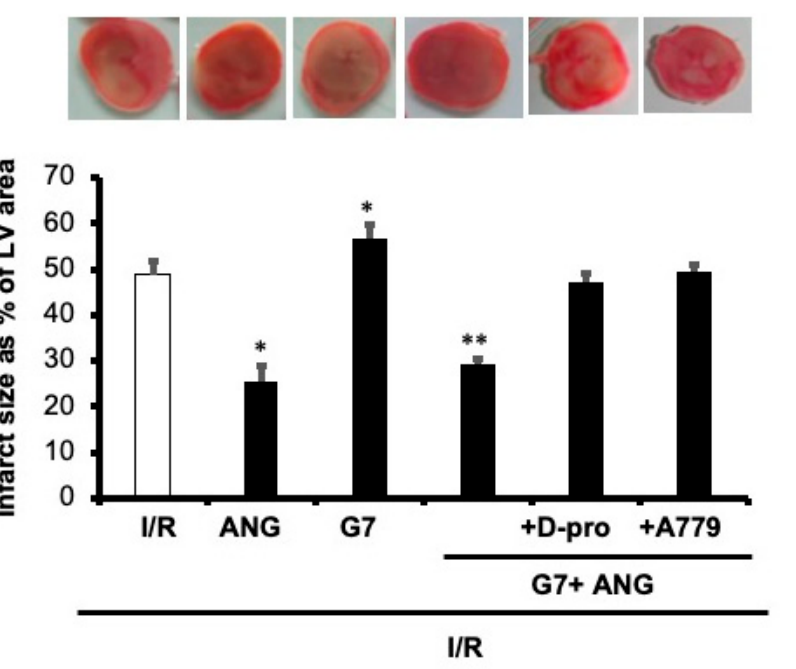
Figure 5. Ang-(1-7) via its Mas Receptor rescues cationic G7 PAMAM-induced myocardial infarction. Infarct size post-I/R injury was determined after treatment with G7 PAMAM in the presence or absence of Ang-(1-7) and its Mas receptor blockers D-Pro and A779 (n = 4). Top panel: representative 2,3,5-triphenyl-2H-tetrazolium chloride-stained heart slices for each treatment condition. Bottom Panel: measured infarct size, normalized to the LV area, in isolated rat hearts at the end of reperfusion. C: control; G7: seventh generation cationic PAMAM dendrimer; Ang-(1-7): angiotensin-1-7; D-Pro: Ang-(1-7) selective antagonist; A779: Ang-(1-7) selective antagonist. Single Asterix * refers to significant difference ( p < 0.05) compared to control I/R alone and double Asterix ** to significant difference ( p < 0.05) compared to G7 values.